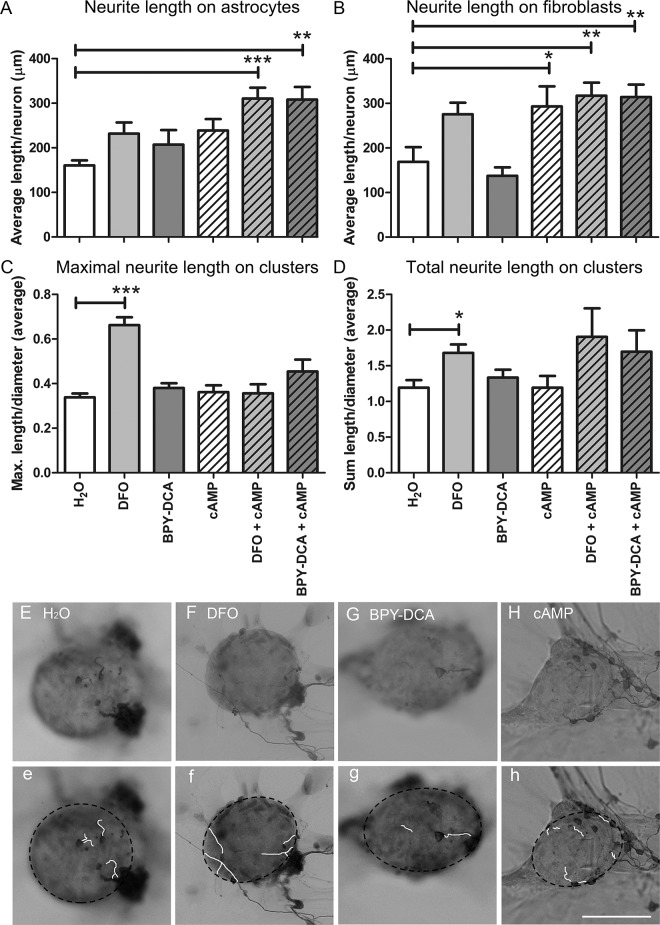
Effects of treatments on neurite outgrowth.Neurite outgrowth from neonatal cortical neurons on the fibroblast and astrocyte cell layers as well as on the clusters in the co-cultures after treatment. cAMP and the combination treatments had a positive effect on outgrowth on the fibroblast layer, whereas only the combination treatments resulted in increased growth on the astrocytes (A, B). DFO was the only treatment resulting in increased growth of neurites on the clusters. Corrected for the cluster diameter, DFO showed an increase in the maximal length (C) and the sum length of the neurites (D). Representative pictures of clusters with neurites (E-H) that were traced using the Neuron J plugin of Image J (e-h, clusters marked by dotted black lines). Statistics: one way Anova with Dunnett’s post-hoc test * p < 0.05, ** p < 0.01, *** p< 0.001 Scale bar = 100 μm.